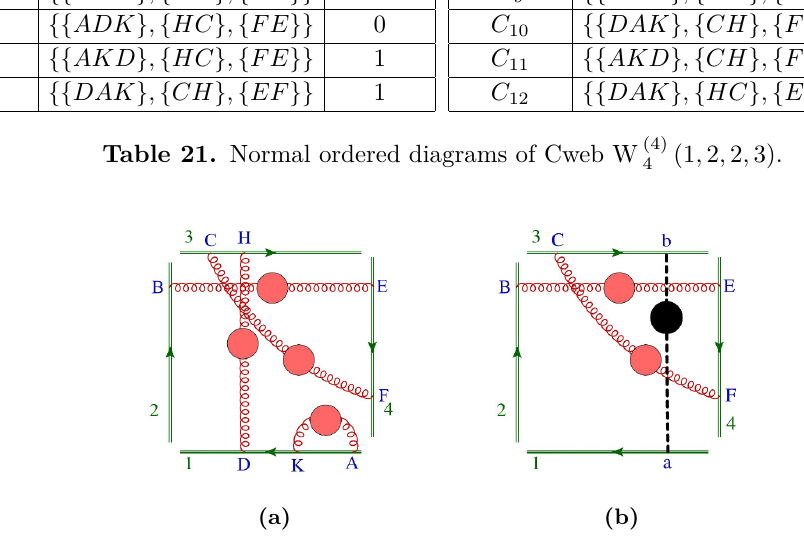
(1 , 2 , 2 , 3) and the associated Fused-Web. Figure 32. Cweb W (4) 4